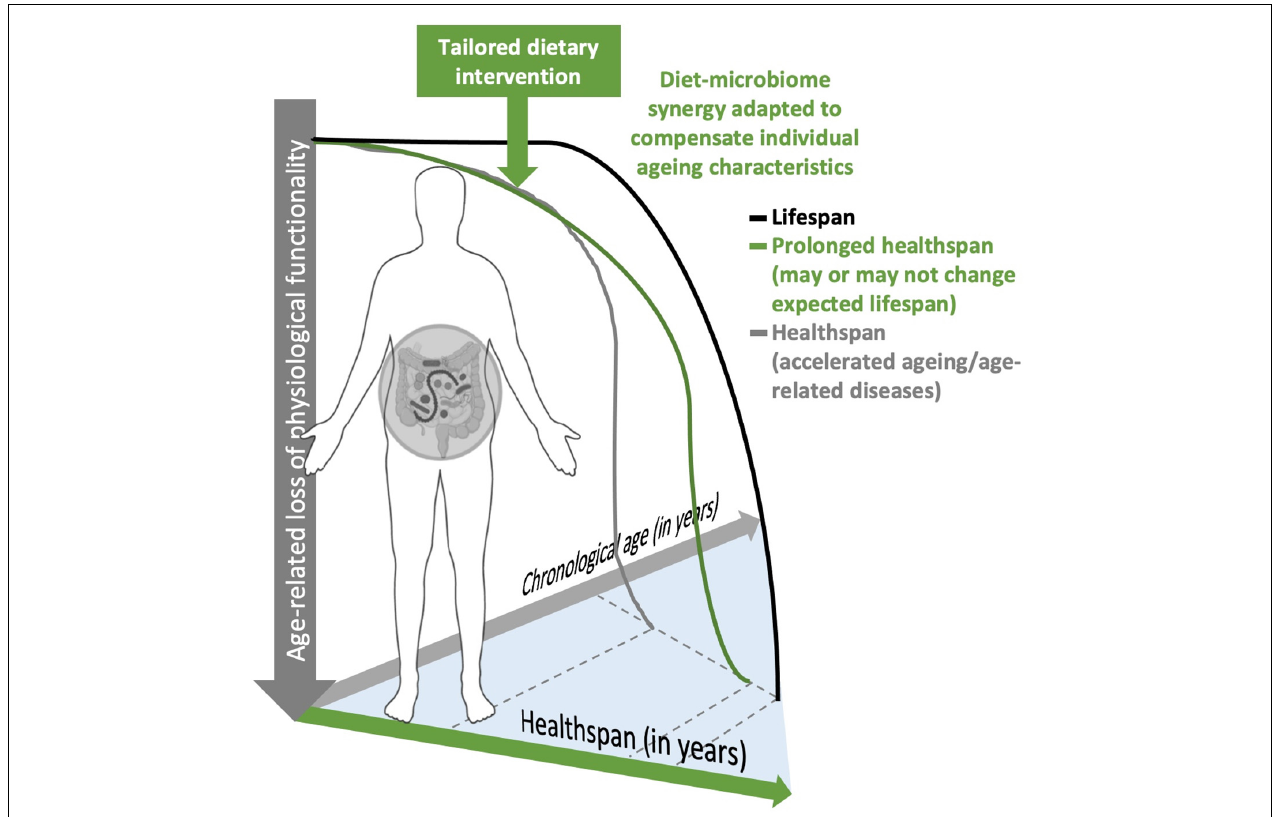
FIGURE 5 | An illustration of how physiology (individualised ageing profile) and host-microbiome synergy may characterise an individual approaching their twilight. Introducing regionally adapted, personalised dietary intervention to select for or nurture the malleable gut microbiome may alter the ageing trajectory to compensate for age-related loss of physiological